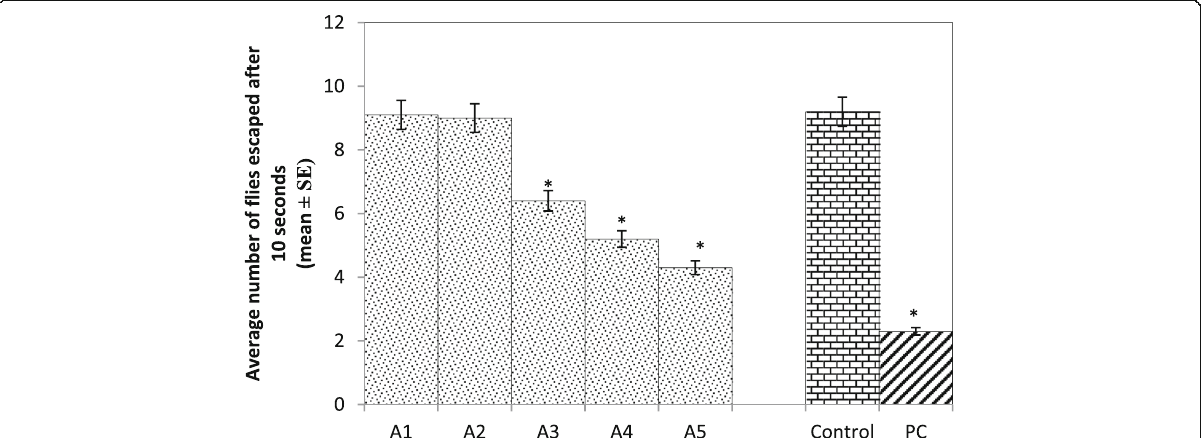
Fig. 1 Climbing assay performed on flies exposed to various doses of arecoline (A1 = 5 μ M arecoline, A2 = 10 μ M arecoline, A3 = 20 μ M arecoline, A4 = 40 μ M arecoline, A5 = 80 μ M arecoline, PC = 10 μ l/ml methyl methanesulphonate), * significant at p < 0.05 compared to